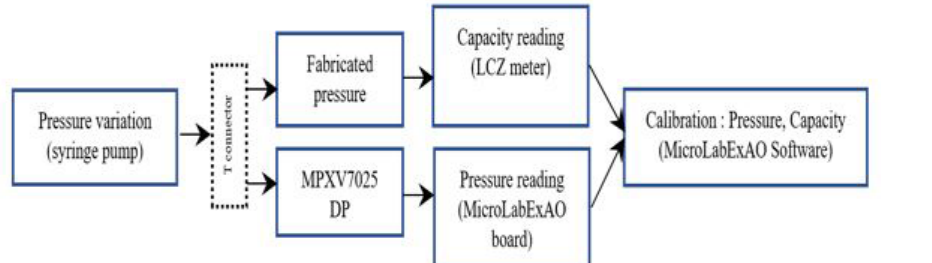
Figure 6. Schematic of the experimental setting.